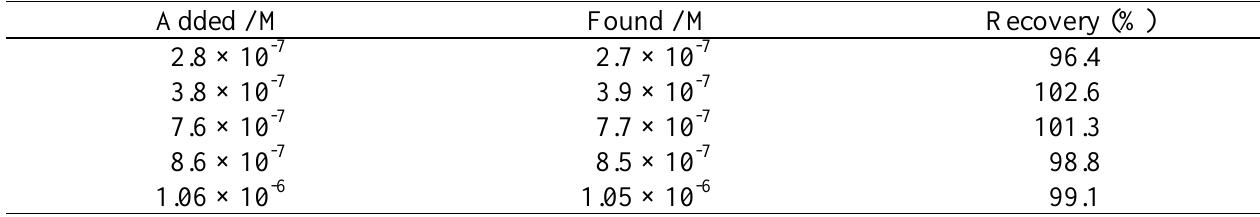
Table 1. Recovery of